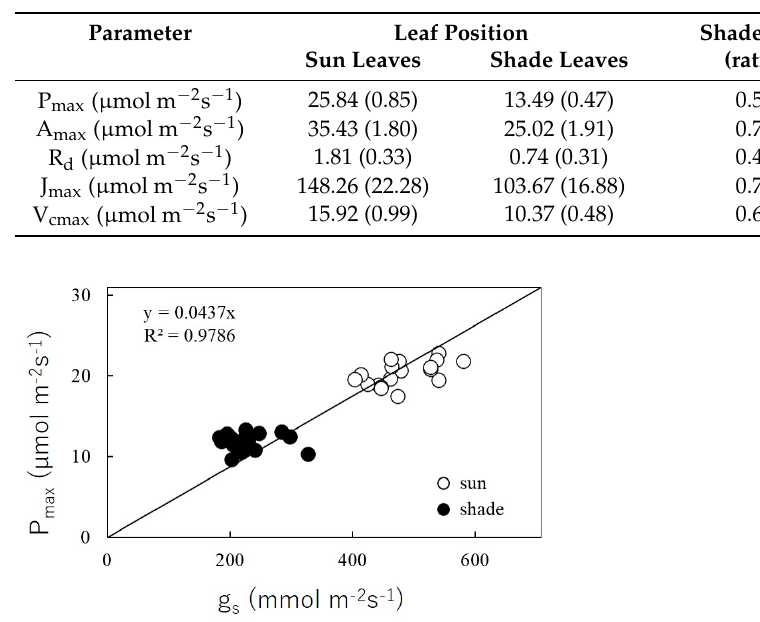
Figure 3. Response of the net photosynthetic rate to photosynthetic photo flux density (PPFD) for sun and shade leaves of Robinia pseudoacacia . Values represent mean ± SE. Table 2. Estimated parameters of the photosynthetic rate curves for sun and shade leaves of Robinia pseudoacacia . Values represent mean (SE in parentheses). ANOVA was used to test the difference between the leaf position at the 0.05 alpha level.